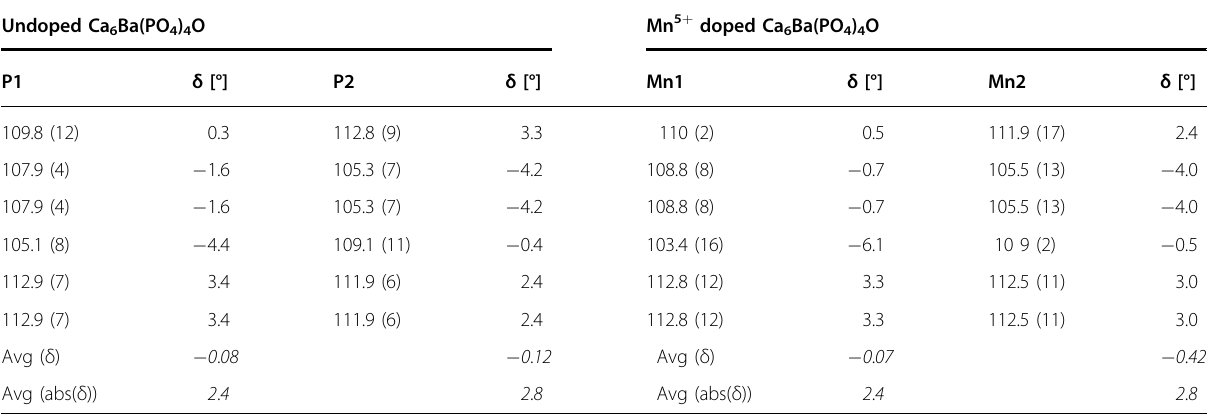
Table 3 O – P – O angles and their difference, δ , to regular tetrahedron angle of 109.5° Undoped Ca 6 Ba(PO 4 ) 4